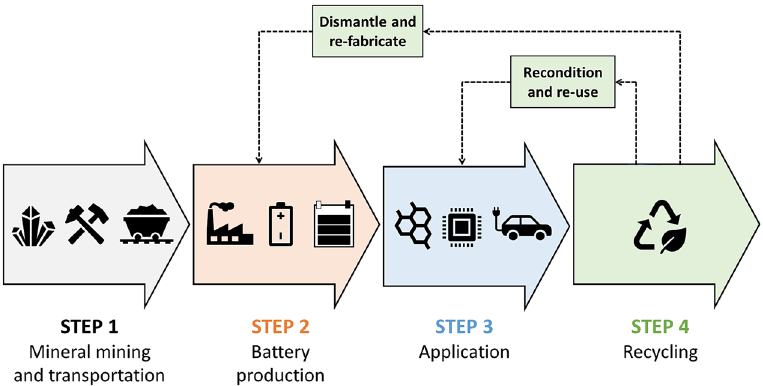
Figure 5. The complete battery cycle from the perspective of automakers.